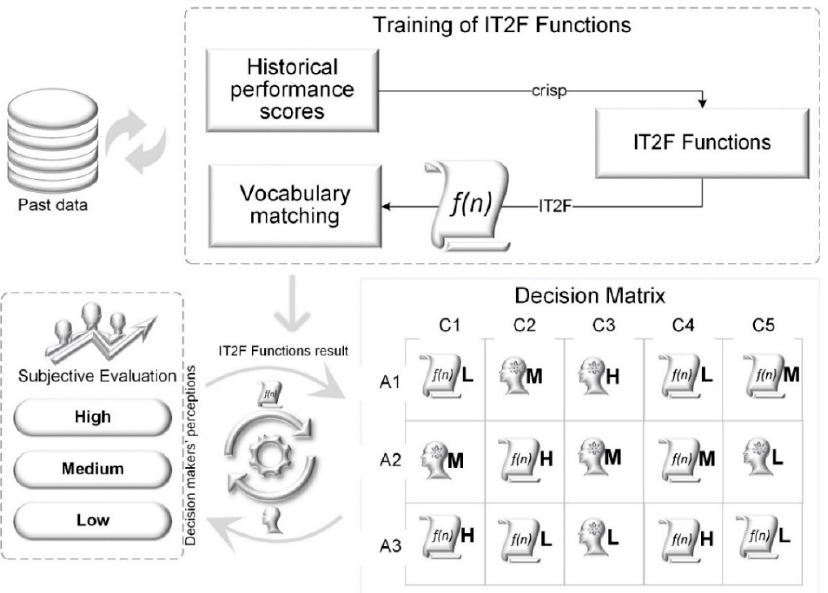
Figure 4. Interactive process of the proposed model.